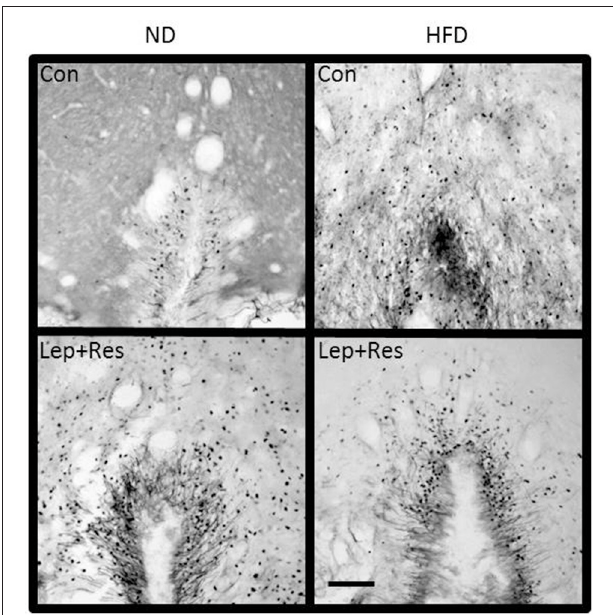
FIGURE 8 | Photomicrographs showing Fos-positive cell nuclei in the median preoptic nucleus (outlined by dashed lines) of rats fed a high fat diet (HFD) and rats fed a normal diet (ND) following centrally administered saline (5 µ l; control) or leptin combined with resistin (7 µ g) (A–D) . *Area is shown in higher magnification in (E,F) respectively. Scale bar = 100 µ m. The rostrocaudal levels of the sections counted were at ∼ 0.12–0.32mm caudal of